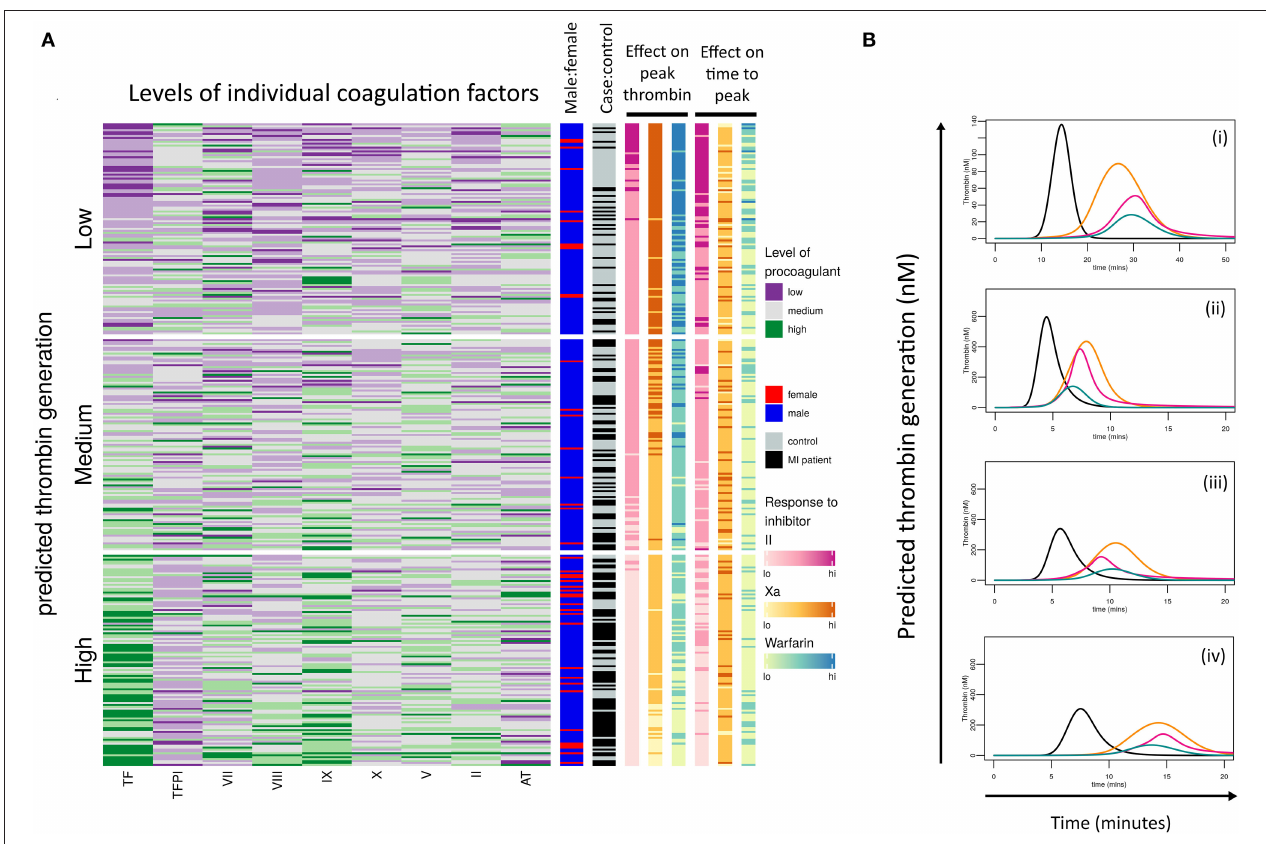
FIGURE 7 | Donor response to procoagulant proteins and coagulation inhibitors is complex. (A) Heatmap of the calculated ability of each donor (cases and controls) to generate thrombin based on their coagulation factor profiles. Donors have been then divided into tertiles depending on their predicted ability to generate low, medium, or high concentrations of thrombin. Each row within the heatmap represents the relative levels of each procoagulant factor and inhibitor for each donor, shown as low (purple), medium (gray), or high (green). The right-hand panels (from left to right) indicate which donors are male (blue) or female (red), which are pMI cases (black) or healthy controls (gray), and the predicted effects of the anticoagulant drugs dabigatran (pink), FXa inhibitor (yellow), and warfarin (blue) on peak thrombin, and time to reach peak thrombin, respectively. (B) Examples of simulation plots from individual donors depicting the predicted generation of thrombin (nM) by their plasma (black line) and the predicted effect of each anticoagulant; dabigatran (pink), FXa inhibitor (orange), and warfarin (green).